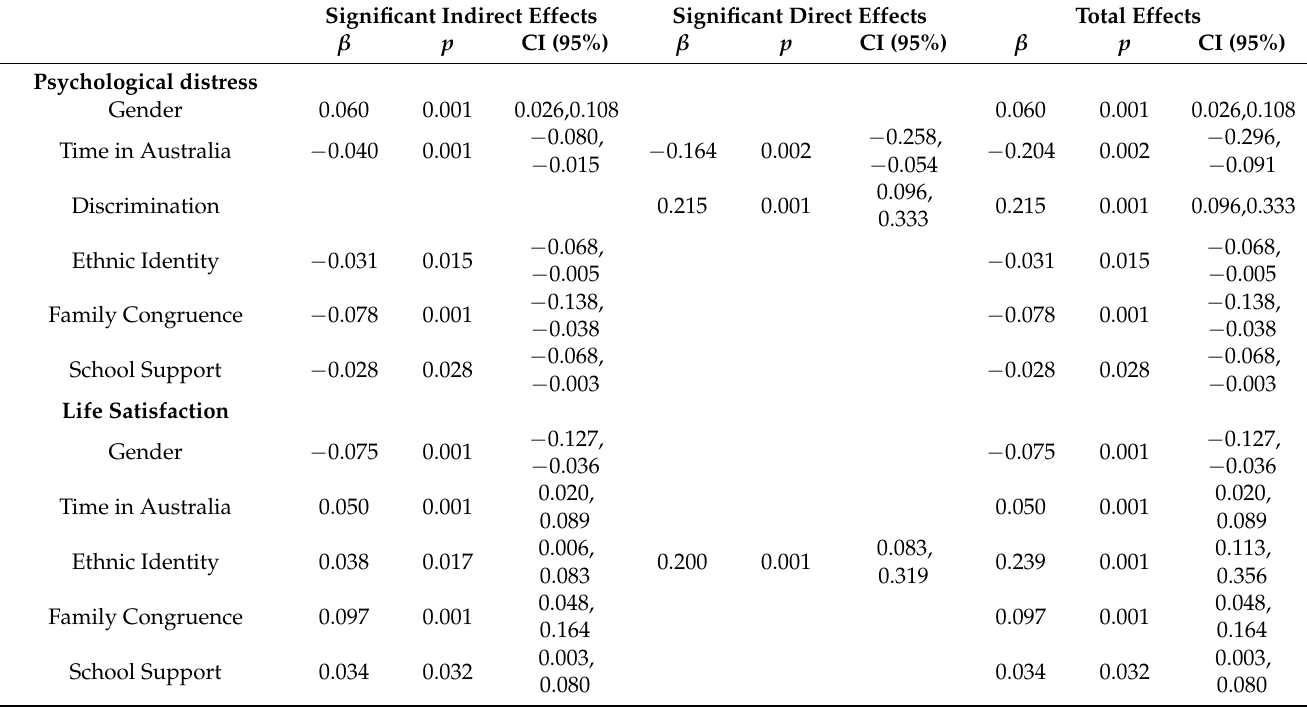
Table 3. Standardized indirect effects (2000 bootstraps, 95%CI) mediated by resilience, direct effects, and total effects on two endogenous variables: significant effects